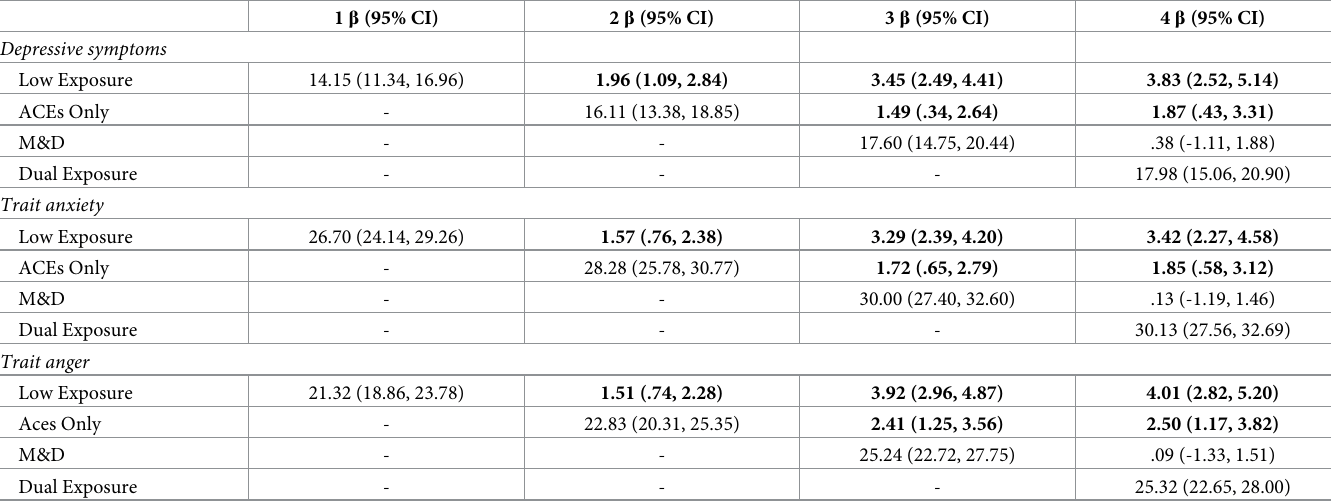
Note . n = 1,171. Bold font indicates p < .05. Values on the diagonal indicate the mean value of each class as reference (i.e., the model intercept). Values above the diagonal indicate differences from the reference class associated with membership in each given class. All coefficients were adjusted for covariates (i.e., age, gender, years lived in the continental U.S., reason for migration, language preference, education level, household income, possession of health insurance, social support, and ethnic